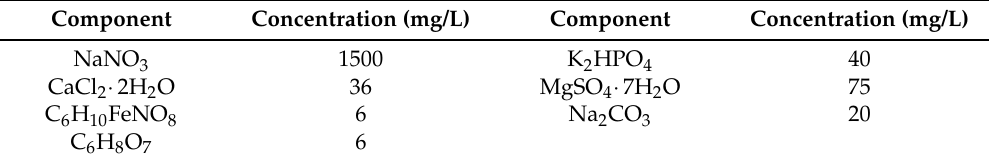
Table 1. Composition of the modified BG11